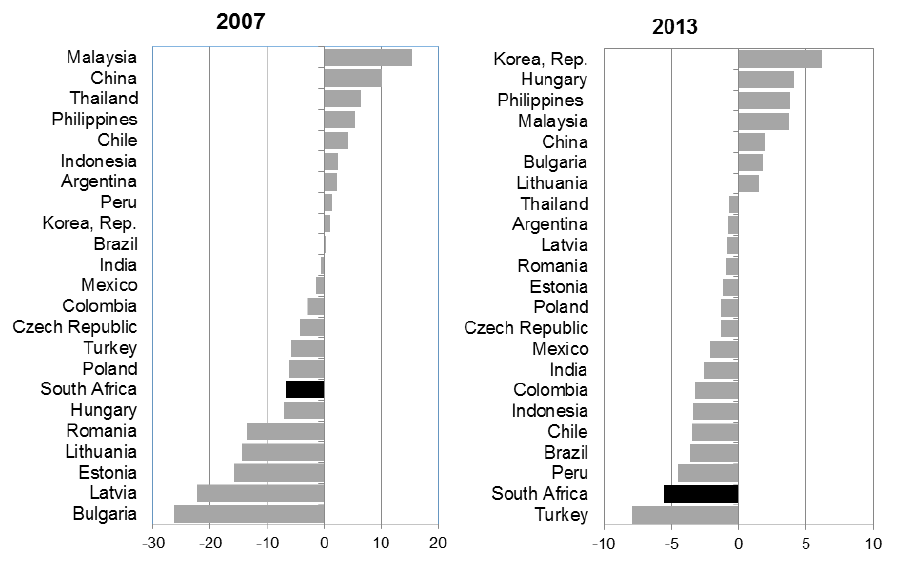
FIGURE 1: Current account balance (% of GDP) Source: Authors’ depiction of data from The World Bank: World Development Indicators.